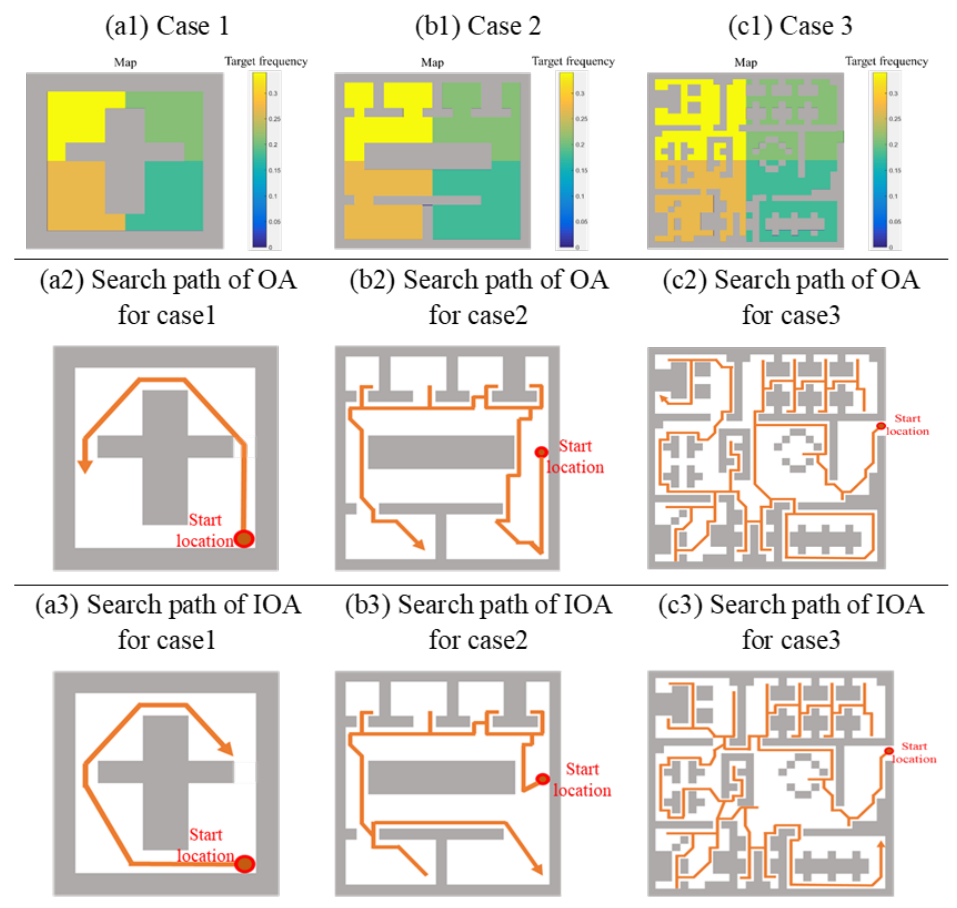
Figure 13. Planed paths based on an algorithm considering target frequency and not considering target frequency.